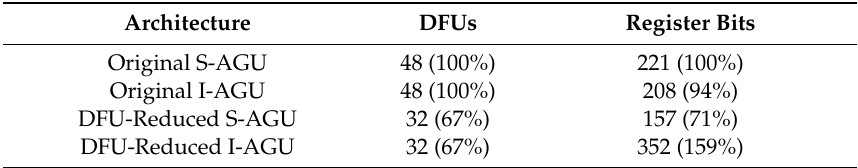
Table 3. Numerical